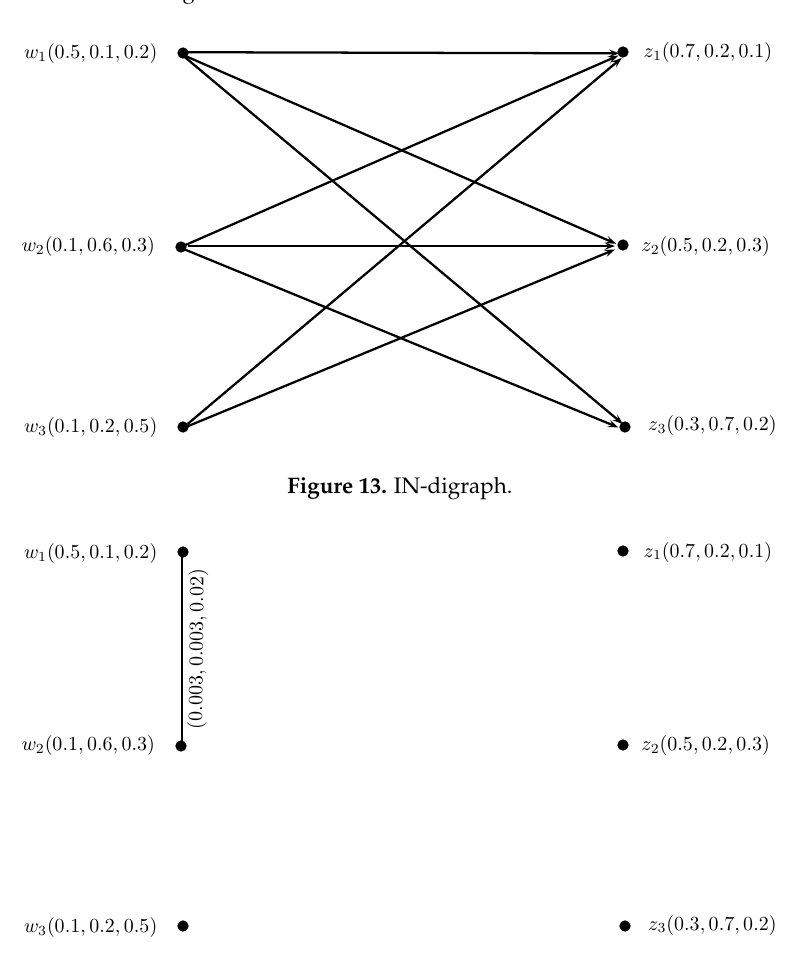
Figure 14. Three-competition